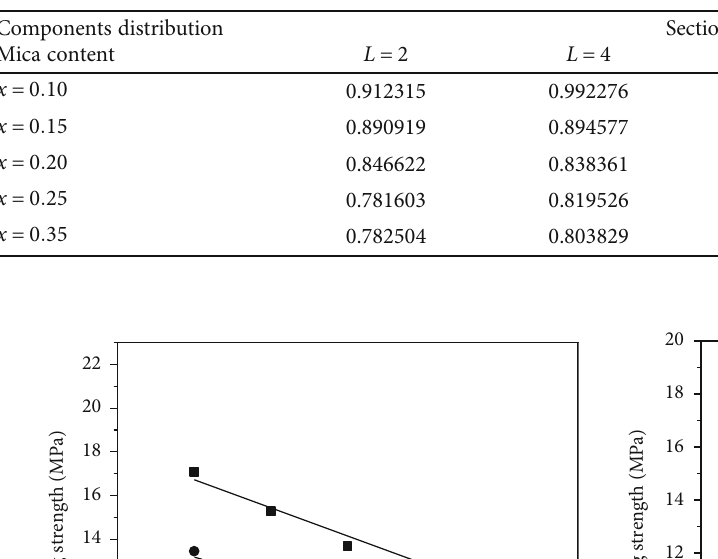
Table 4: Fractal results of fracture numerical test section of specimens with di ff erent fabrics.